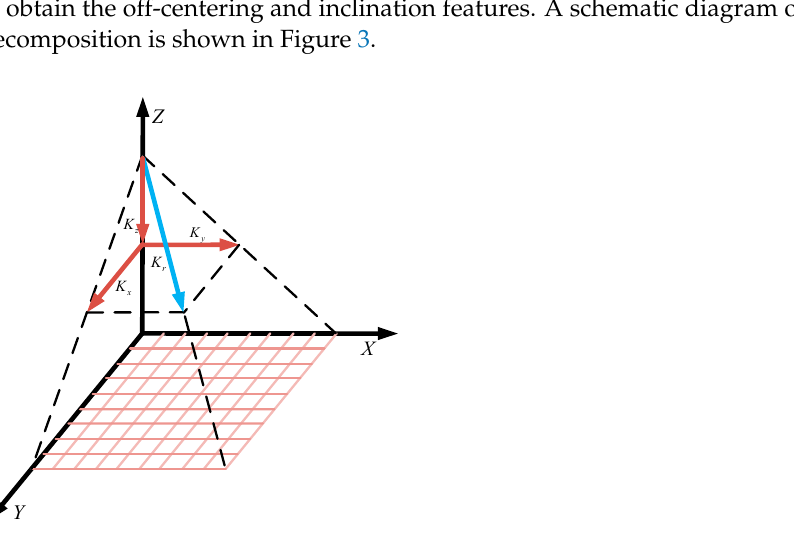
Figure 3. Schematic diagram of the radar wavenumber decomposition. K r is the radar wavenumber. Its magnitude remains constant in the synthetic aperture interval, while its direction varies. It can also be decomposed into three directions → → → K z . K x and K y denote the azimuth wavenumber and range wavenumber, respectively, and whose magnitudes at an arbitrary time t a can be defined as K x ( t a ) and K y ( t a ) . To obtain the wavenumber support region of point P at